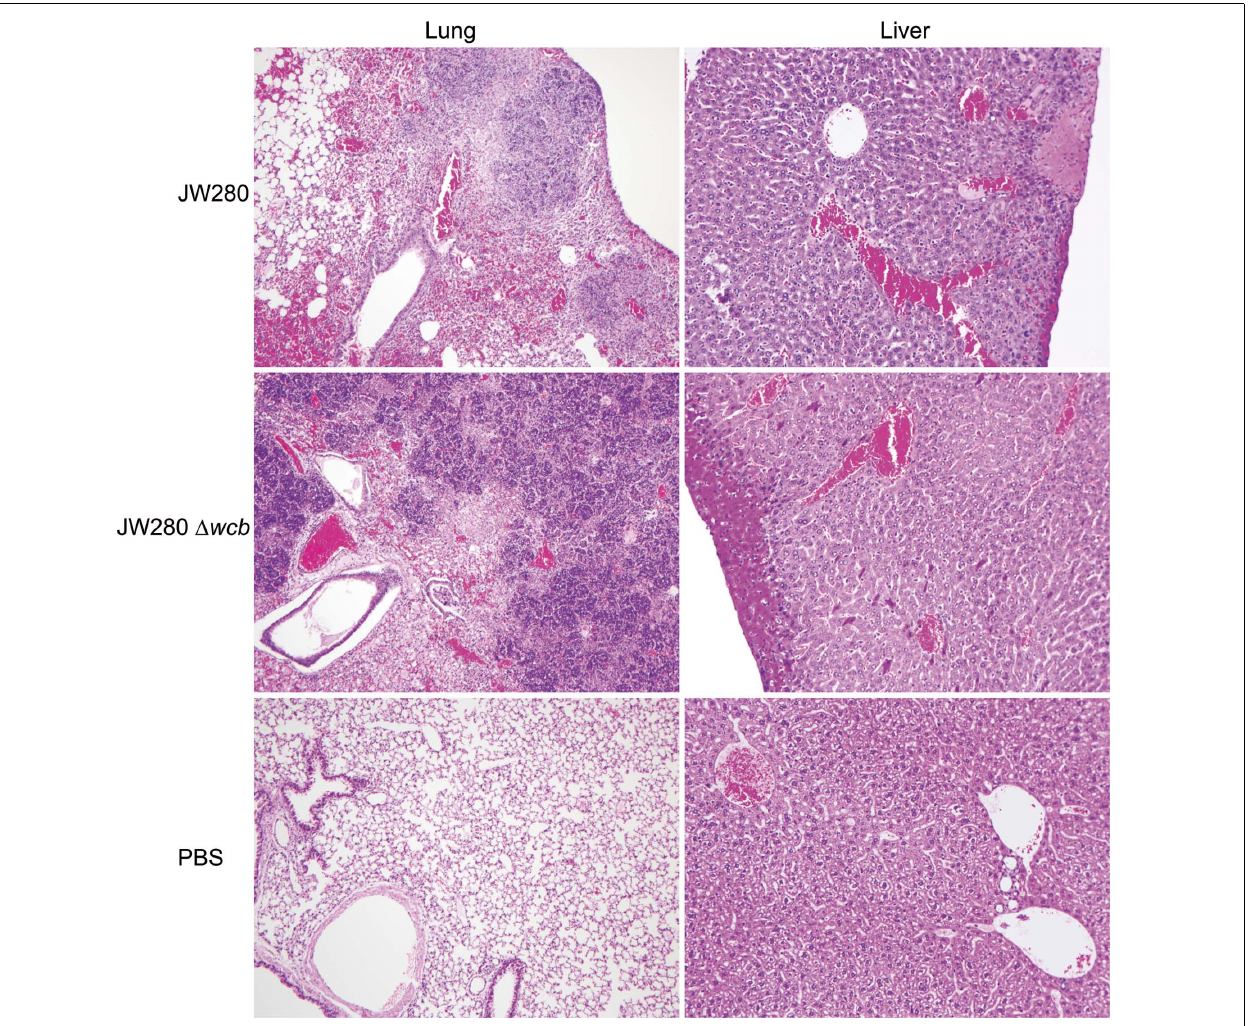
FIGURE 3 | Histological analysis of B. pseudomallei -infected tissues. Photomicrographs of representative tissue samples from SKH1 mice infected i.n. with JW280 (10 4 CFU), JW280 (cid:2) wcb (10 6 CFU), or PBS mock-infected